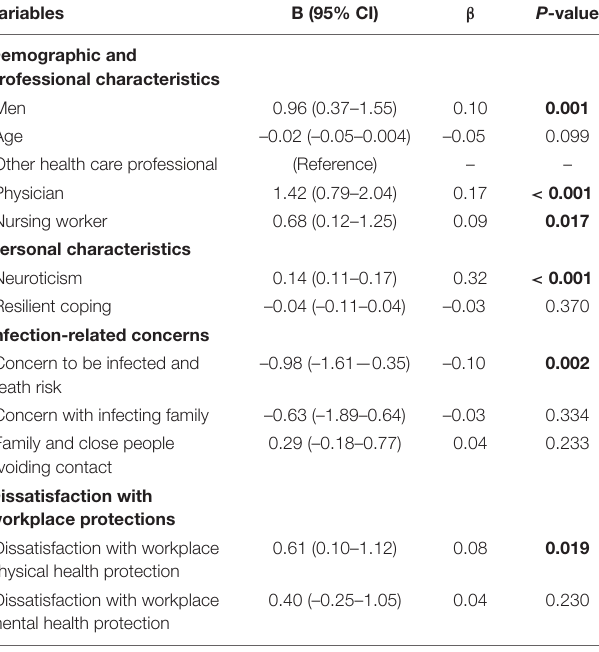
TABLE 3 | Multivariable model of emotional exhaustion indicators among Brazilian frontline health care workers during the COVID-19 pandemic.